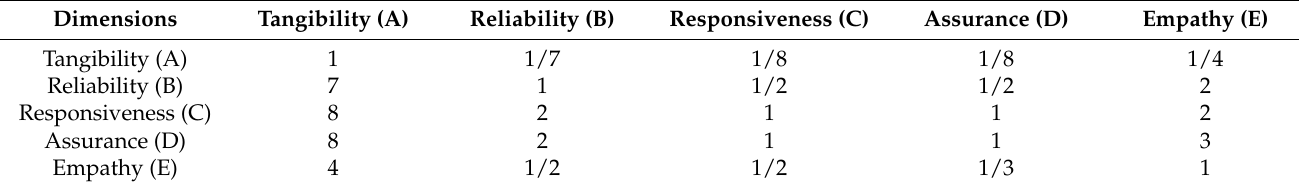
Table 5. The de-fuzzified pairwise comparison matrix of five dimensions from FANP